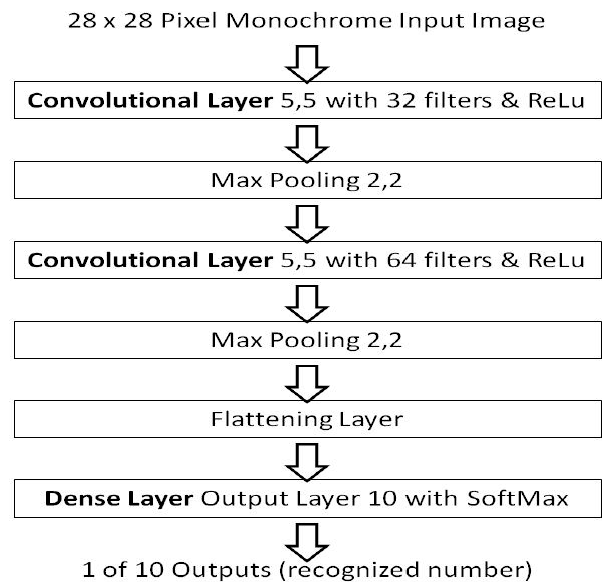
Figure 2. The model architecture of the benchmark model, by